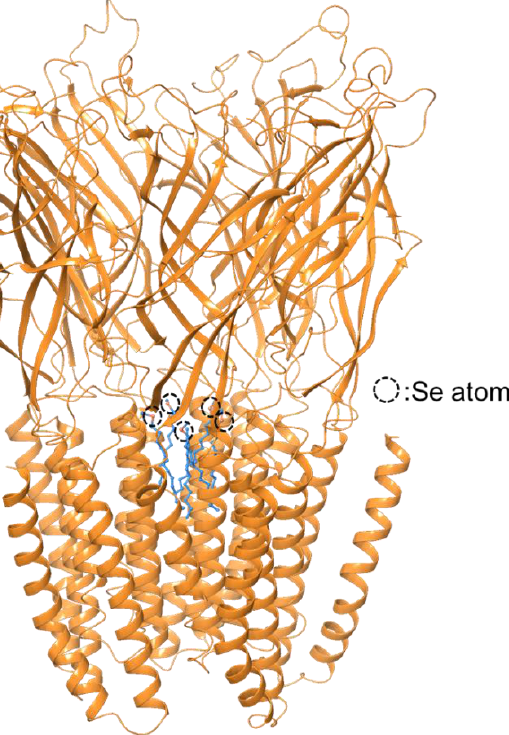
Figure 5. Crystal structures of transmembrane proteins Leukotriene C4 synthase (PDB ID: 3B29) ( A ) and pLGIC pentamer (PDB ID: 4IL4) ( B ) using SeDDM as the phasing detergent. The hydrocarbon chains of Se-DDM are shown in sky-blue.